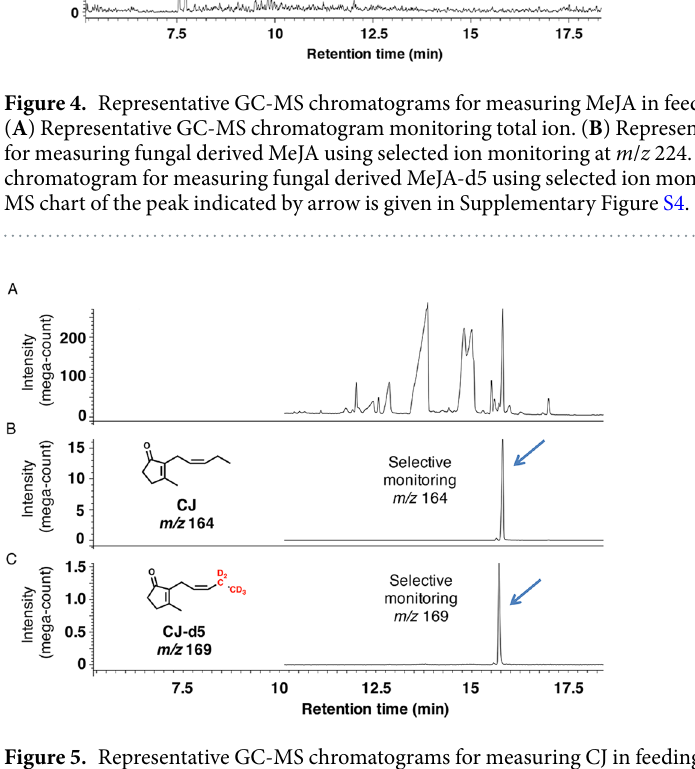
Figure 5. Representative GC-MS chromatograms for measuring CJ in feeding experiment using LA-d5. ( A ) Representative GC-MS chromatogram monitoring total ion. ( B ) Representative GC-MS chromatogram for measuring fungal derived CJ using selected ion monitoring at m / z 164. ( C ) Representative GC-MS chromatogram for measuring fungal derived CJ-d5 using selected ion monitoring at m / z 169. Representative MS chart of the peak indicated by arrow is given in Supplementary Figure